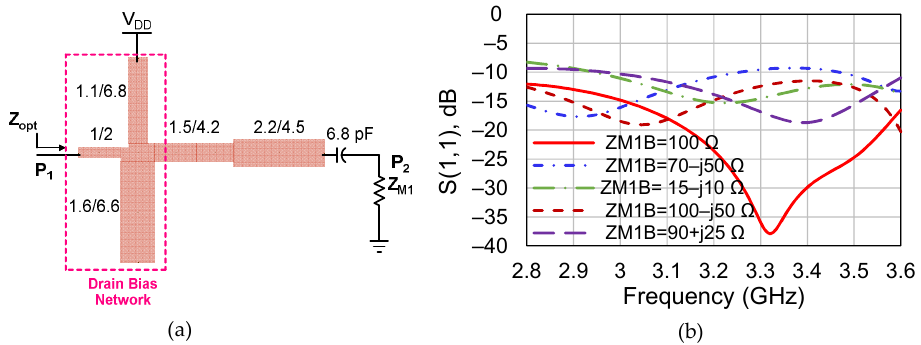
Figure 6. ( a ) Output matching network of the main (dimensions (width/length) are in mm) and ( b ) input reflection coefficient when port 1 is normalized with respect to 2 R opt for different load impedance at the break